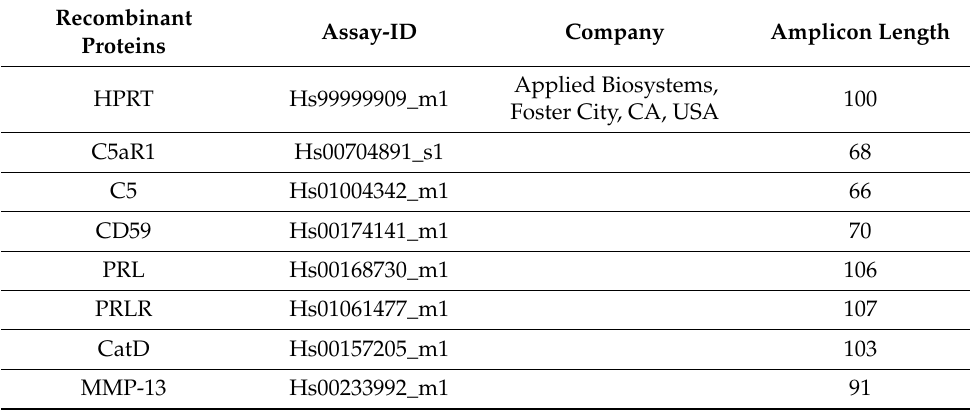
Table 1. Oligonucleotides used for qPCR